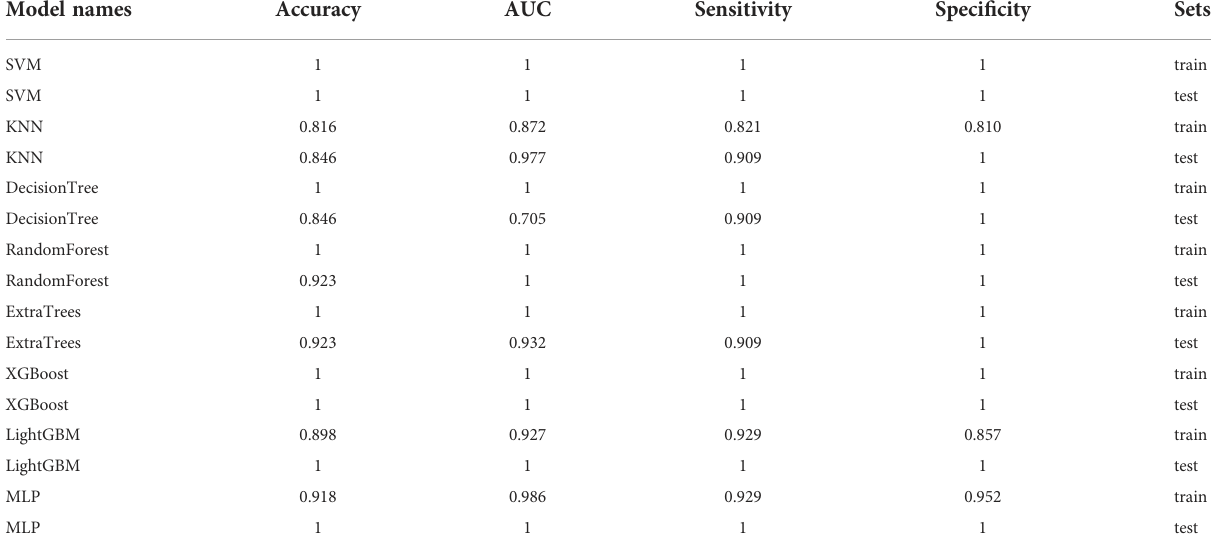
TABLE 16 Each evaluation index of the best performance of 100 random groupings in eight machine learning algorithms. Model